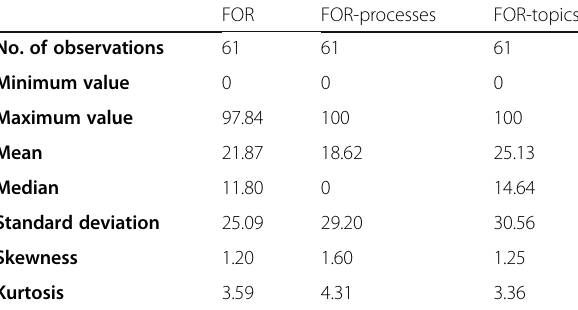
Table 2 Summary statistics for FOR and its dimensions FOR FOR-processes